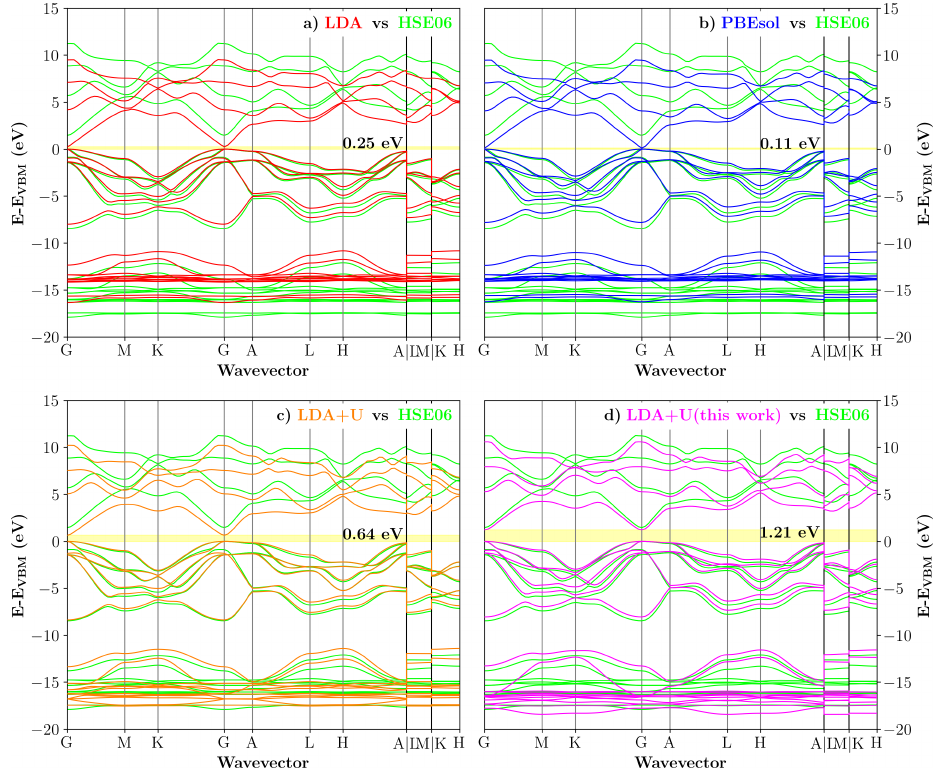
Figure 5. Hybrid DFT (HSE06) electronic band-structure of the (1:1) superlattice compared to: ( a ) LDA, ( b ) PBEsol, ( c ) LDA+U with U-parameters taken from Carvalho et al. [14], and ( d ) LDA+U with U-parameters obtained in this work. The shaded area highlights the